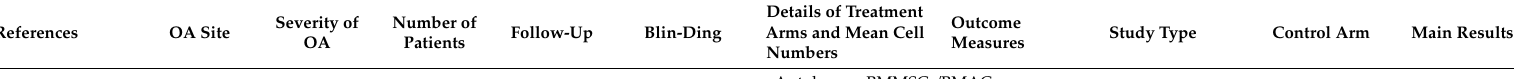
Table 2. Included studies, categorized by tissue origin and sorted by study type, number of patients and